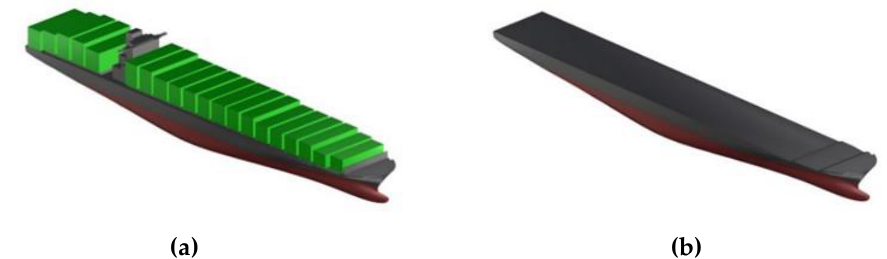
Figure 1. Modeling of the 8000 TEU-class container ship. ( a ) Design of model with superstructure. ( b ) Design of model without superstructure.